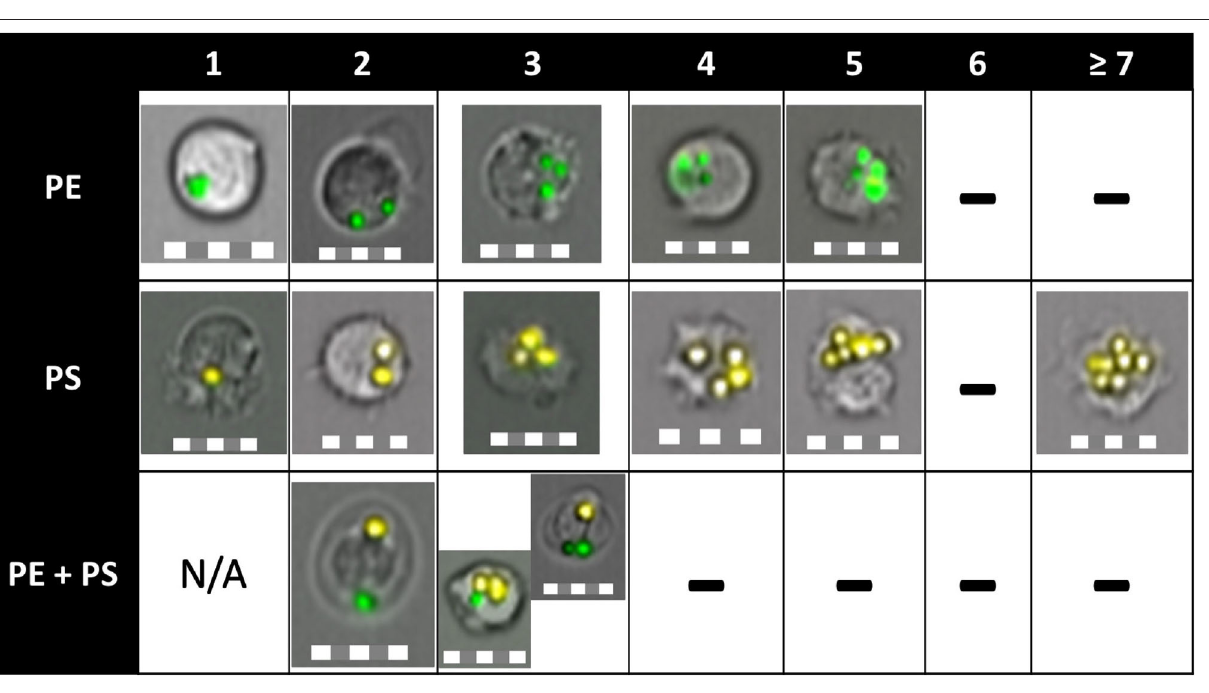
FIGURE 5 | Phagocytic capacity of Atlantic salmon immune cells to ingest PE-MP, PS-MP, or both. The column names indicate the number of particles inside a cell. “-” indicate the absence of cells that engulfed that number of particles. Cells were able to ingest up to five PE particles and up to eight PS particles, which translated to a higher phagocytic capacity of the cells toward PS-MP. HK and blood cells were able to phagocytose two different polymer types at the same time (shown on 3rd row, engulfed PE-MP and PS-MP), a fact proven for the first time in this study. Pictures were obtained by imaging flow cytometry from all tissues, timepoints, and MP concentrations. Scale = 10 µ